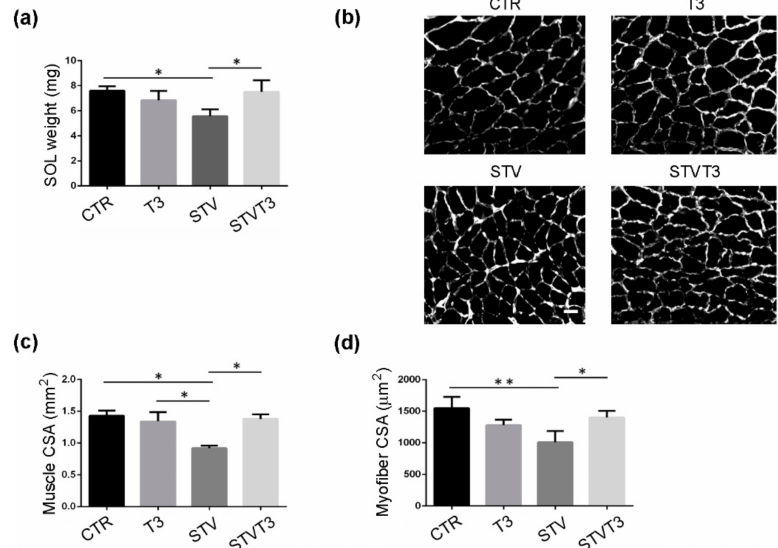
Figure 2. T3 counteracts starvation-induced skeletal muscle loss in soleus. ( a ) Soleus muscle weight after 48 h of indicated treatments. n = 3 mice per each condition. Data are presented as means ± SD. STV and T3 significantly interact ( p = 0.003) by two-way ANOVA; * p < 0.05 by post hoc Tukey’s HSD test. ( b ) Representative pictures of soleus muscles with laminin staining, 48 h after starvation. Scale bar = 20 µ m. ( c ) Morphometric analyses of the whole soleus CSA. n = 3 mice per each condition. Data are presented as means ± SD; STV has a significant e ff ect ( p = 0.035); STV and T3 significantly interact ( p = 0.016) by two-way ANOVA; * p < 0.05 by post hoc Tukey’s HSD test. ( d ) Morphometric analyses of myofiber CSA. n = 3 mice per each condition. Data are presented as means ± SD; STV has a significant e ff ect ( p = 0.017); STV and T3 significantly interact ( p = 0.003) by two-way ANOVA;